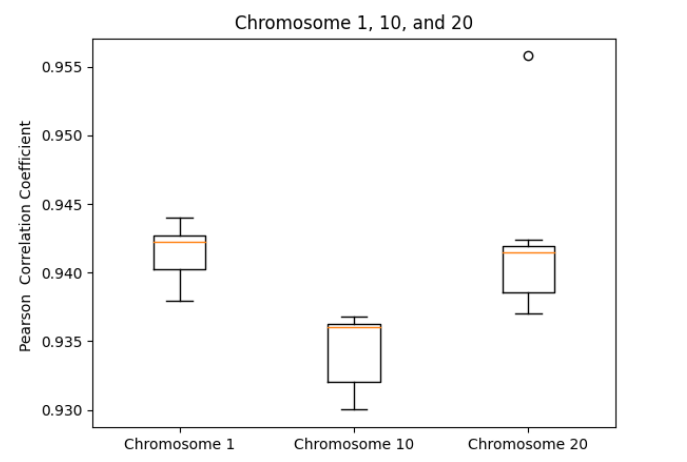
Figure 7. PCC box plots by